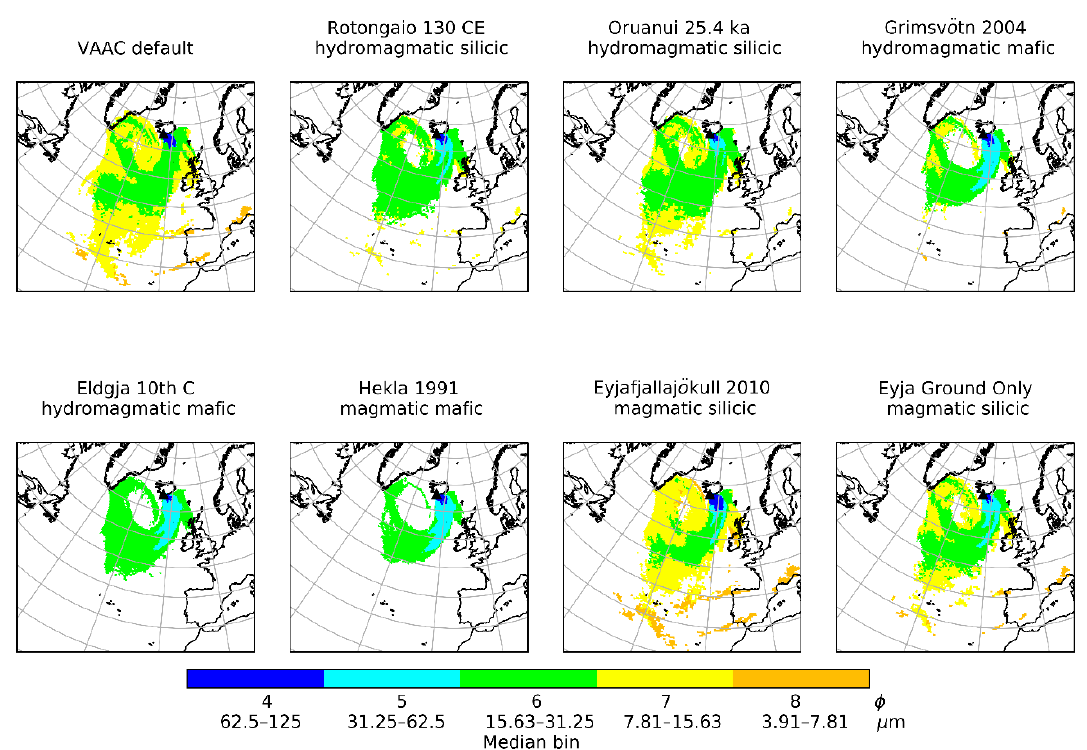
Figure 14. Modelled median grain size of deposits using PSDs from hydromagmatic and magmatic eruptions with silicic and mafic/intermediate compositions.